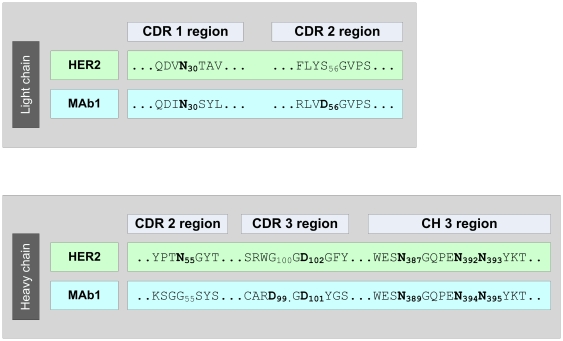
Partial sequences of HER2 and Mab1.